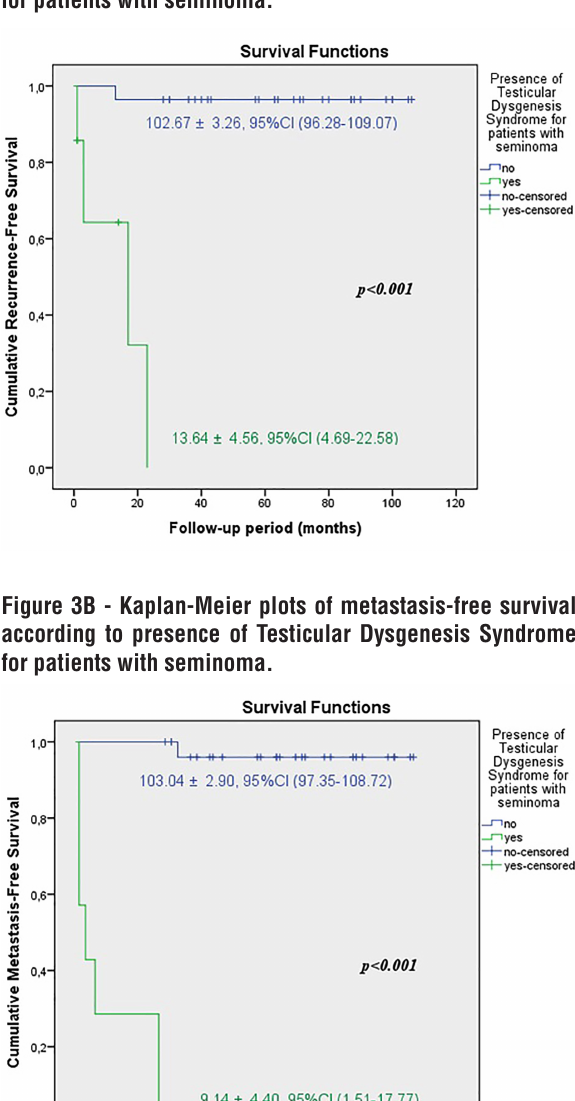
Figure 3C - Kaplan-Meier plots of cancer-specific survival according to presence of Testicular Dysgenesis Syndrome for patients with